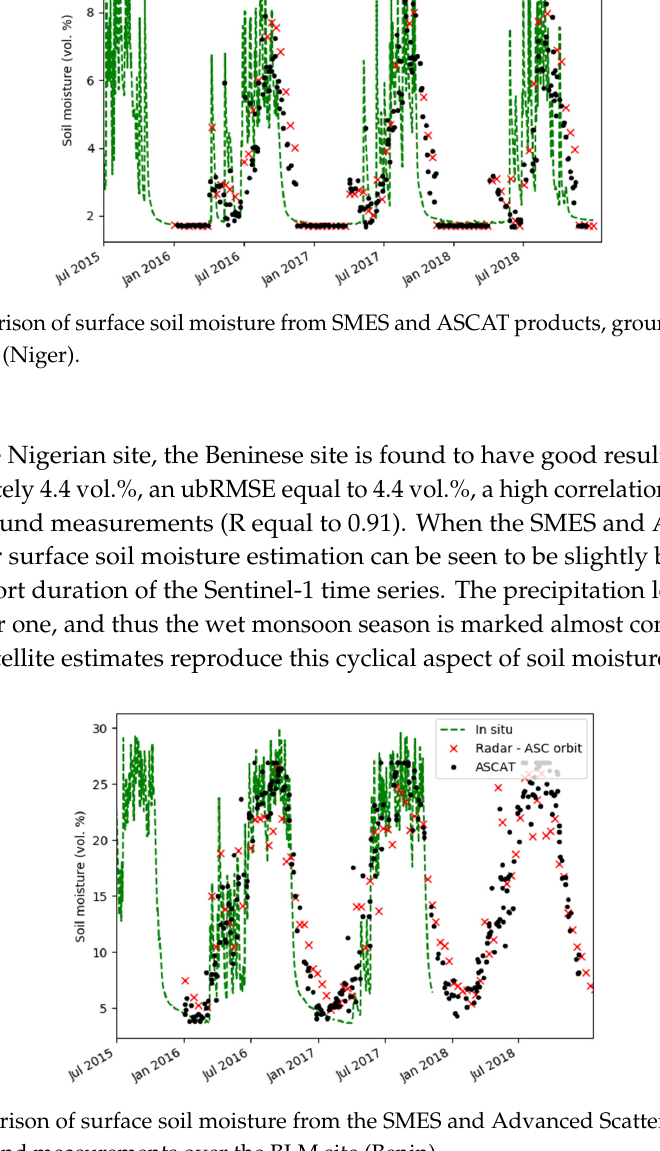
Figure 8. Comparison of surface soil moisture from the SMES and Advanced Scatterometer (ASCAT) products, of ground measurements over the BLM site